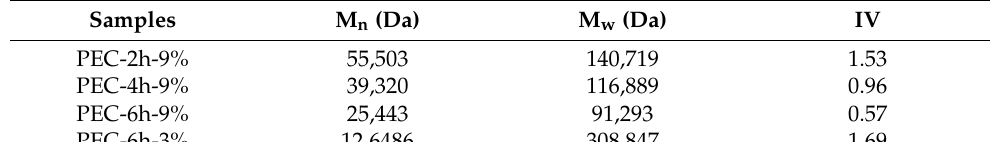
Table 3. Molecular weight parameters and intrinsic viscosity of extracted pectins vs. different processing times and acetic acid concentrations.